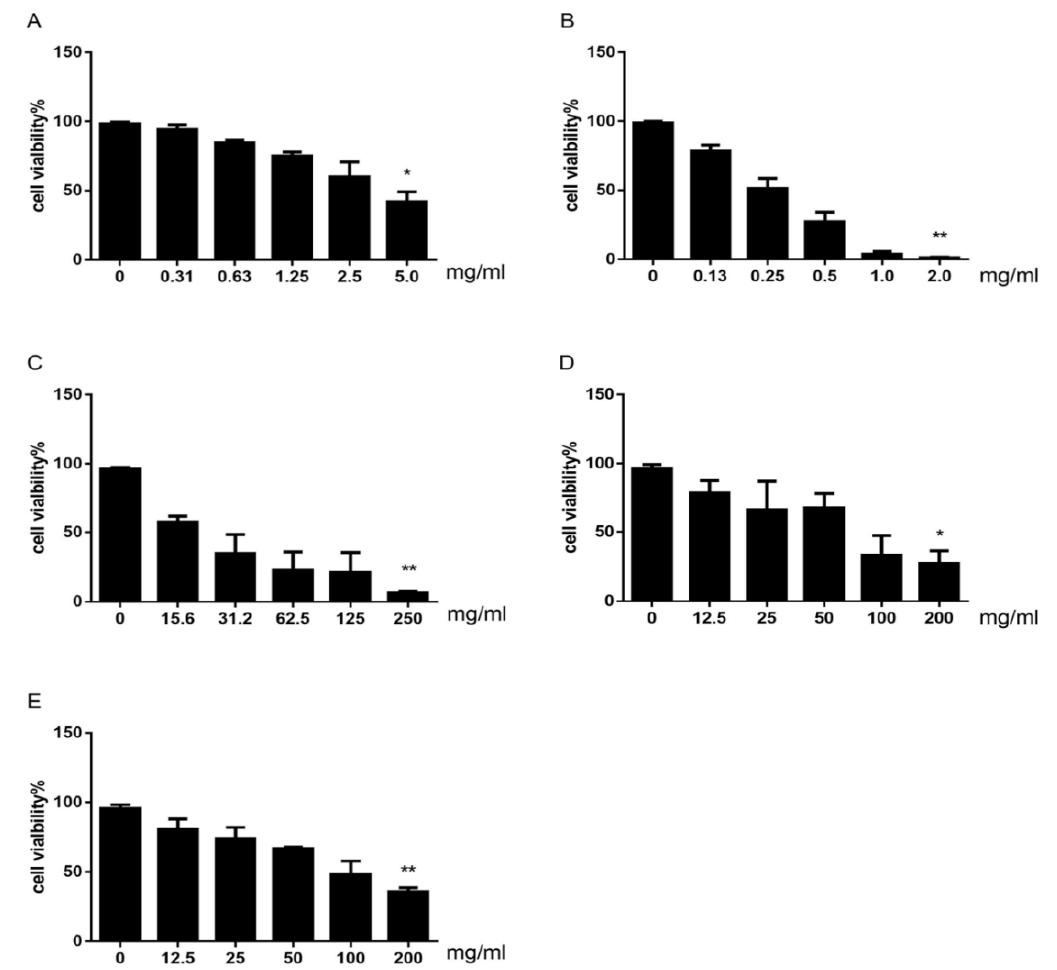
Figure 4. Cell viability of HepG2 cells treated with CDAE ( A ); CDEE ( B ); dictamnine ( C ); obakunone ( D ); and fraxinellone ( E ) for 48 h, as estimated by the CCK-8 assay (Values are expressed as means ± SDs, * p < 0.05, ** p < 0.01 compared with the control group. n = 3).